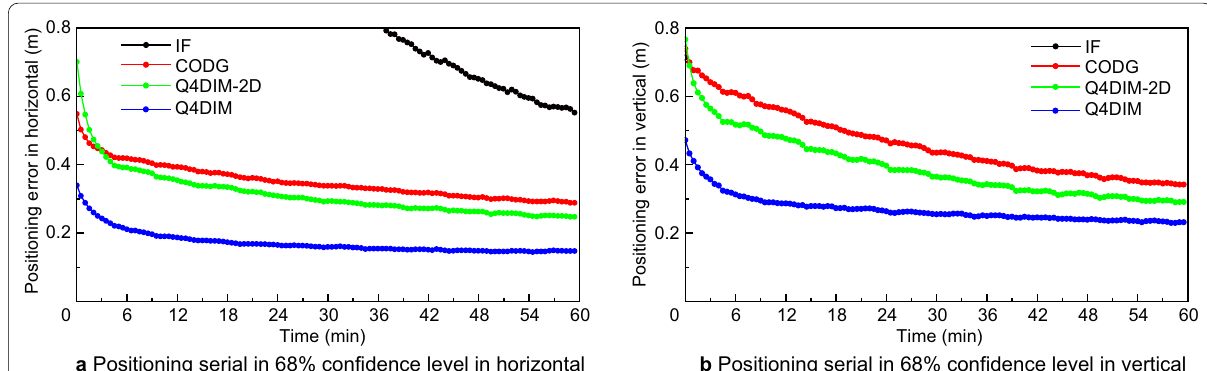
Fig. 10 Single frequency PPP convergence serial for DOY 001–030, 2014, respectively. While for different ionospheric delay processing mode with IF, CODG, Q4DIM‑2D and Q4DIM, the results are denoted in black, red, green, and blue, respectively